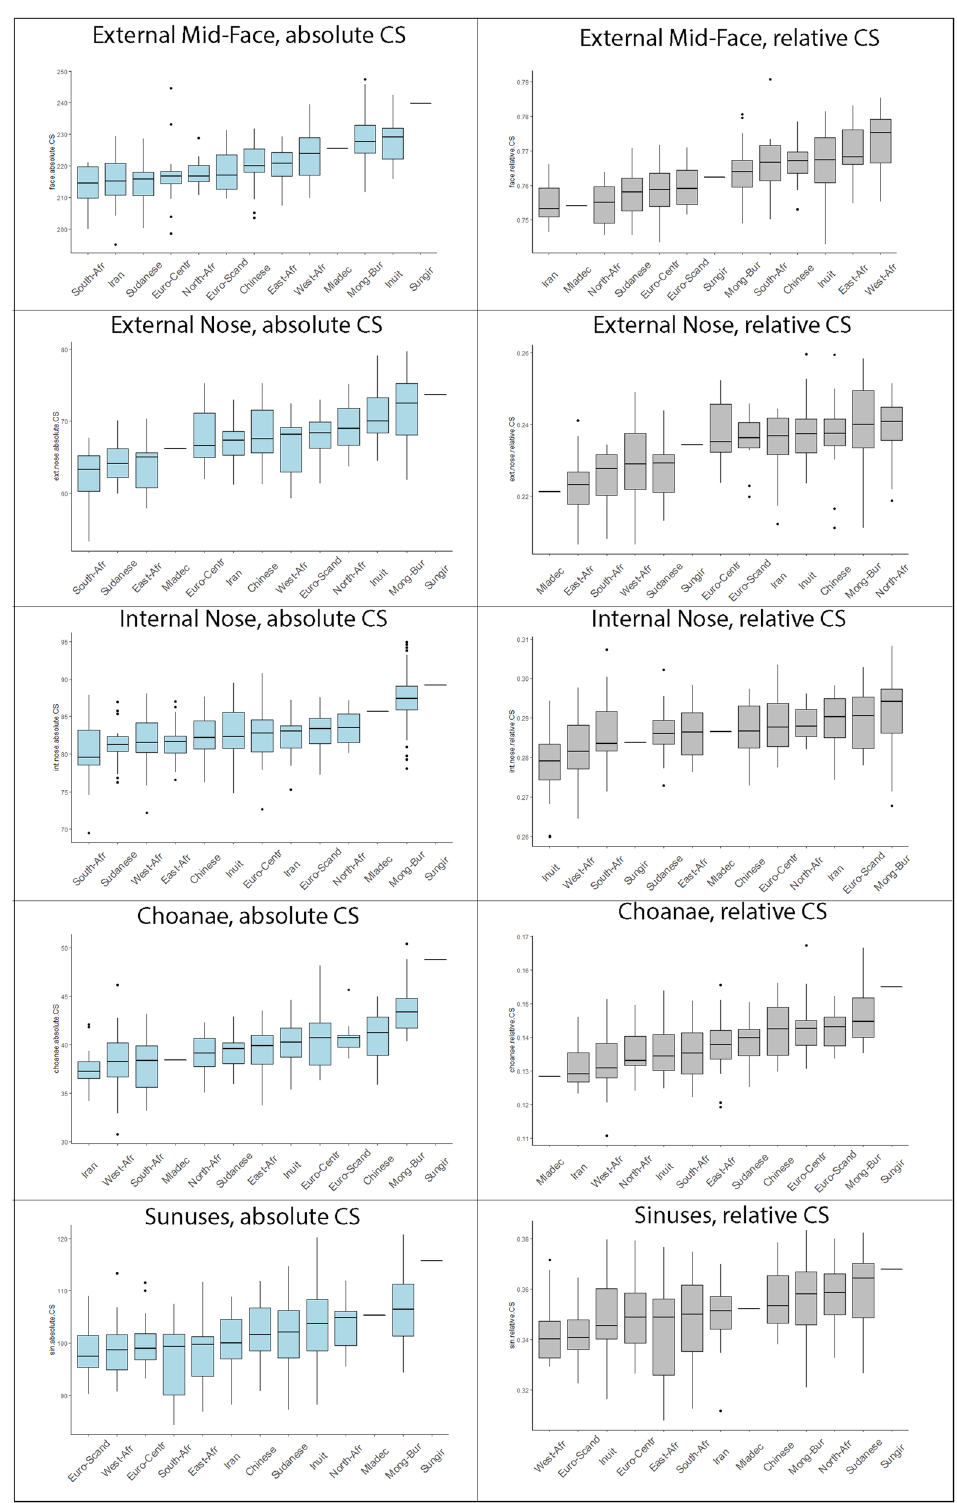
Figure 4. Absolute and relative centroid size for different anatomical regions. The groups in the boxplots are sorted by the median centroid size in ascending